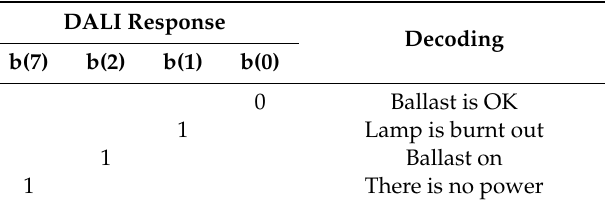
Table 2. DALI Response decoding.